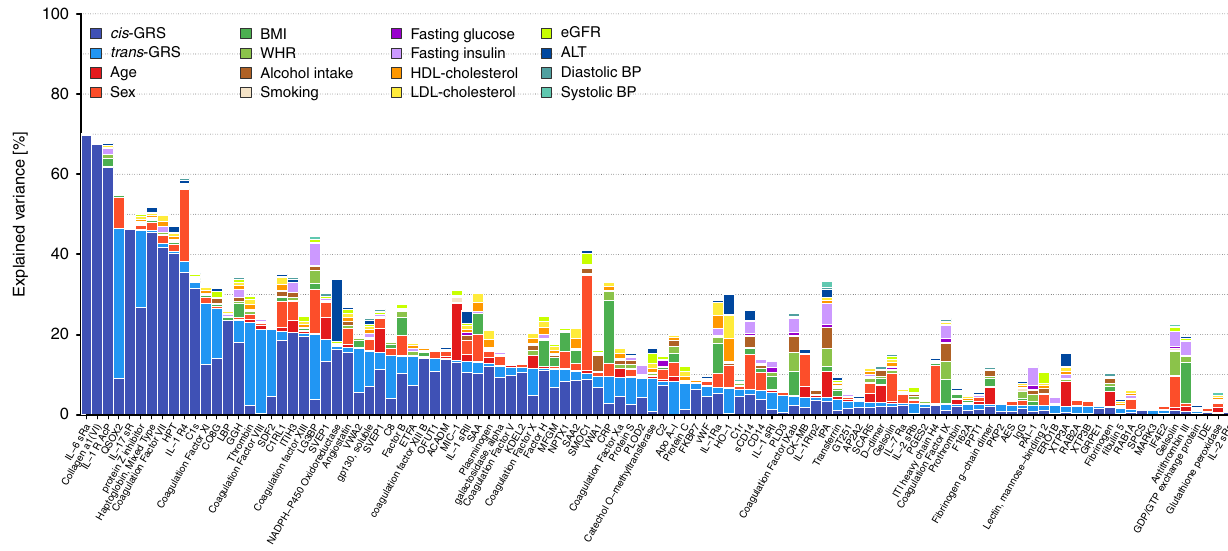
Fig. 4 Stacked bar chart showing the results from variance decomposition of plasma abundances of 106 aptamers targeting candidate proteins. For each candidate protein a model was fi tted to decompose the variance in plasma levels including all 16 factors noted in the legend. These analyses were done based on 8006 participants with complete data. cis / trans -GRS = weighted genetic risk score based on all single nucleotide polymorphisms associated with the aptamer of interest acting in cis and trans , respectively. BMI (body mass index), WHR (waist-to-hip ratio), HDL (high-density lipoprotein), LDL (low-density lipoprotein), eGFR (estimated glomerular fi ltration rate), ALT (alanine amino transaminase), and BP (blood We identi fi ed a few variants with evidence for vertical pleiotropic effects, including rs2289252 a cis -pQTL for coagula- tion factor XI, which was speci fi cally associated ( p < 5 × 10 − 8 ) with members of the coagulation cascade such as Kinigon 1, alpha-2-macroglobulin, kallikrein B, plasma (Fletcher factor) 1, and thrombin.